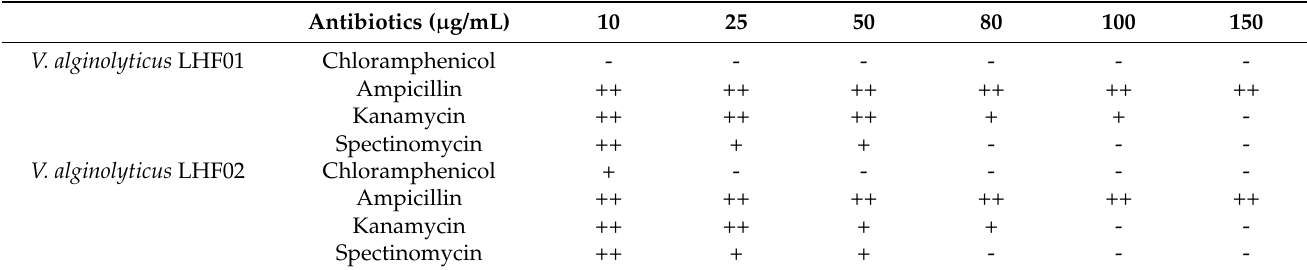
Table 1. Antibiotic resistance of V. alginolyticus LHF01 and LHF02.